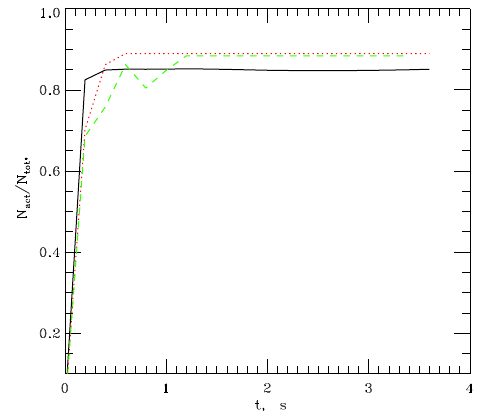
Figure 7. The dependence of the average turbulent kinetic energy on time with aerosol for N tot = 5500cm − 3 (dotted curve, case 3) and without aerosol (solid curve, case 5). The other parameters cor- respond to non-equilibrium case with low intensive turbulence (see Table